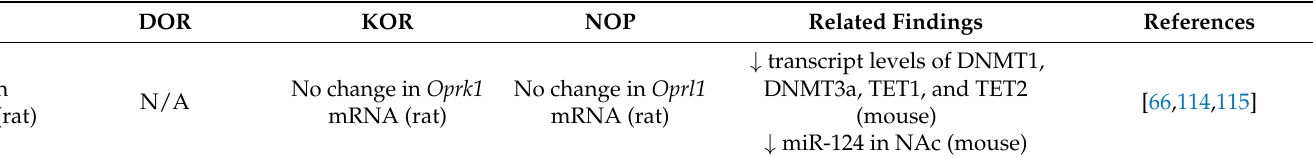
Table 1. Effects of drugs of abuse on mRNA levels of brain opioid receptors in vivo unless otherwise